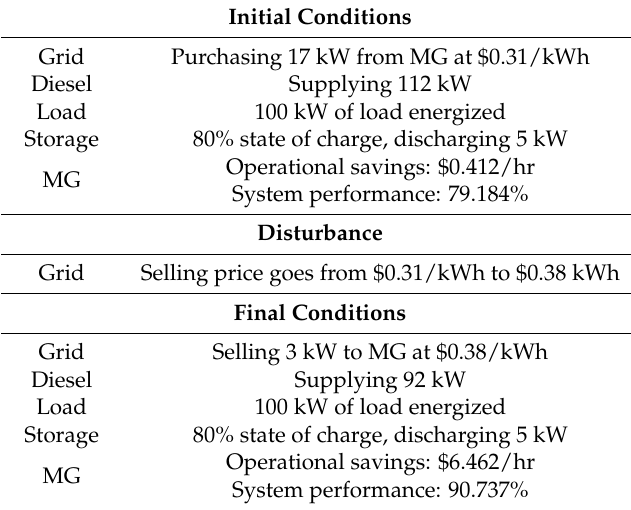
Figure 14. Discrete search space for post-disturbance condition. The objective functions, to minimize cost and maximize performance, form the plot axes. Each circle represents a solution. Grid-Connected Mode: Change in Battery Goal This scenario shows how agents react and respond to a sudden change in goals made by the user (MG operator). The operator changes the relative importance of the MG revenue to the health and longevity of the battery. In other words, the operator influences the agents’ decision-making by conveying goals dynamically. In this case, the MG conditions are initially identical to the final conditions from the previous case discussed above (Table 5). The grid price is $0.38/kWh, which is below the charging cost of the battery ($.45/kWh), and the battery SOC is assumed to be 60%. The user-defined goal is now changed from equal importance of cost and performance (i.e., w 1 = w 2 ) to making the battery health and longevity (performance) more important than the MG revenue or cost, i.e., the weights are adjusted to w 2 > w 1 . The battery charging and discharging agents negotiate regarding this change in the goal, and ultimately come to the decision to change the initial 5 kW battery discharge rate to charging at 25 kW to bring up the battery SOC. As shown in Table 5, by making this charge, the pre-disturbance profit of $6.46/hr reduces to the post-disturbance profit of $3.78/hr. The screen shots showing the pre- disturbance and post-disturbance cost versus performance characteristics for the charging and discharging performance of the battery are shown in Figures 15 and 16, respectively. They show the